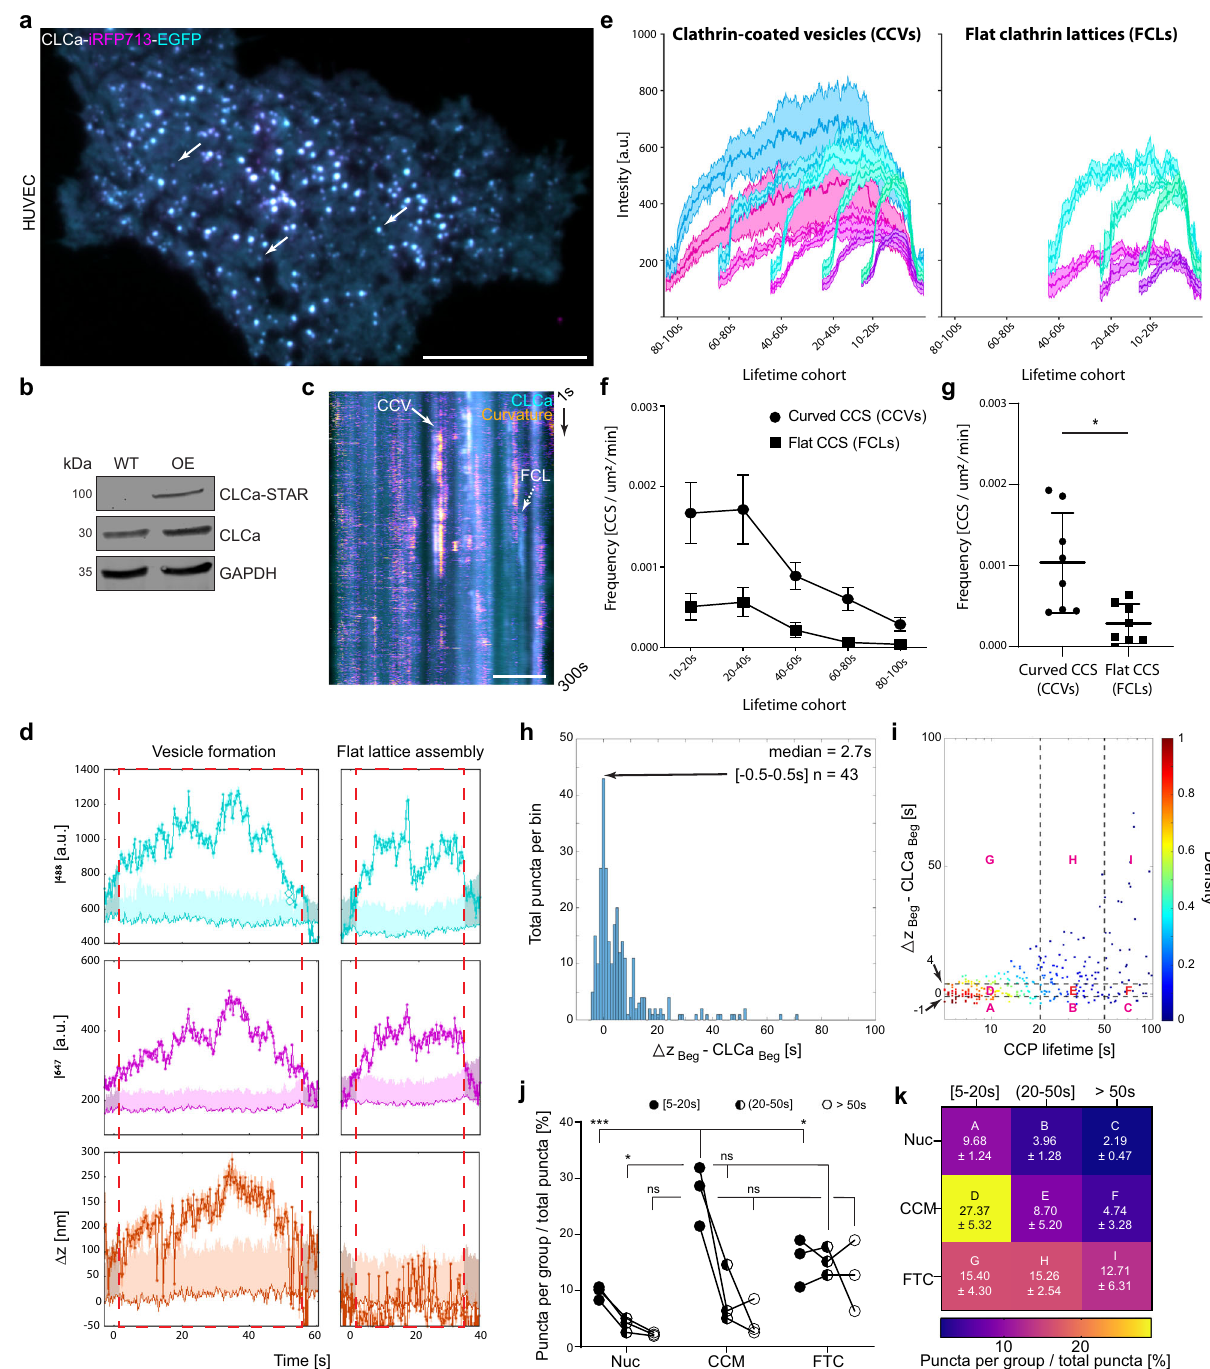
the 10 images of the NanoGird were stacked based on averaged intensity, and created image was used to generate a calibration fi le required for the emission signal separation using a Fiji plugin (Cairn Image Splitter version 1.5 — https:// imagej.nih.gov/ij/plugins/cairn-splitter.html). Post splitting grid pictures were saved as they will be used for image registration. Then, the fl at fi eld correction fi les and experimental data fi les were split using the calibration fi le. Flat fi eld correction images were then stacked for each emission signal based on average intensity. Each channel of the experimental data was then background subtracted. Reasonable size (at least 100 ×100 pixels) ROI was drawn outside of the cell area. The mean intensity from the ROI was then subtracted from each channel for every image accordingly. Next, we performed a fl at fi eld correction. First, the live-cell data bit depth is changed to 32-bits. The max intensity value is measured from an exci- tation matching fl at fi eld. Then every image was normalized using the respective fl at fi eld correction image. Using a built-in Fiji function, we performed a bleach correction (simple ratio method) for both channels separately. The 647nm